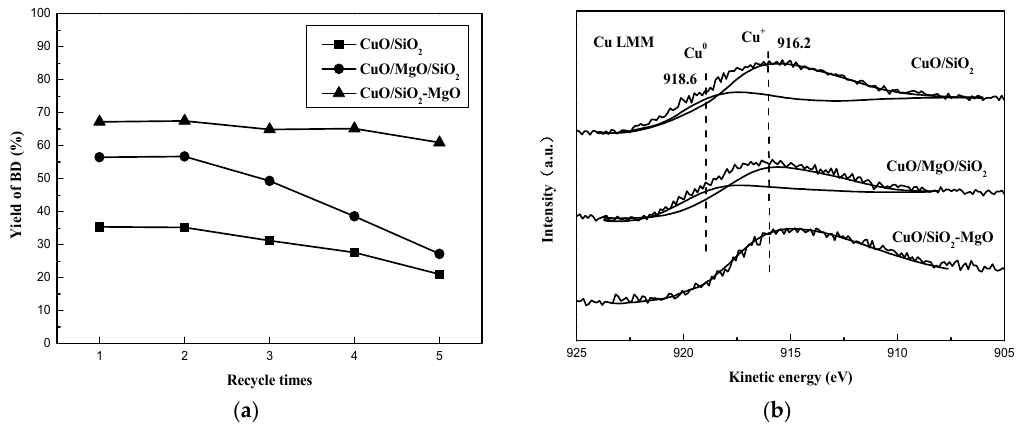
Figure 16. Cyclic test of catalysts ( a ) and Cu LMM XAES spectra of catalysts after 5 cycles ( b ).